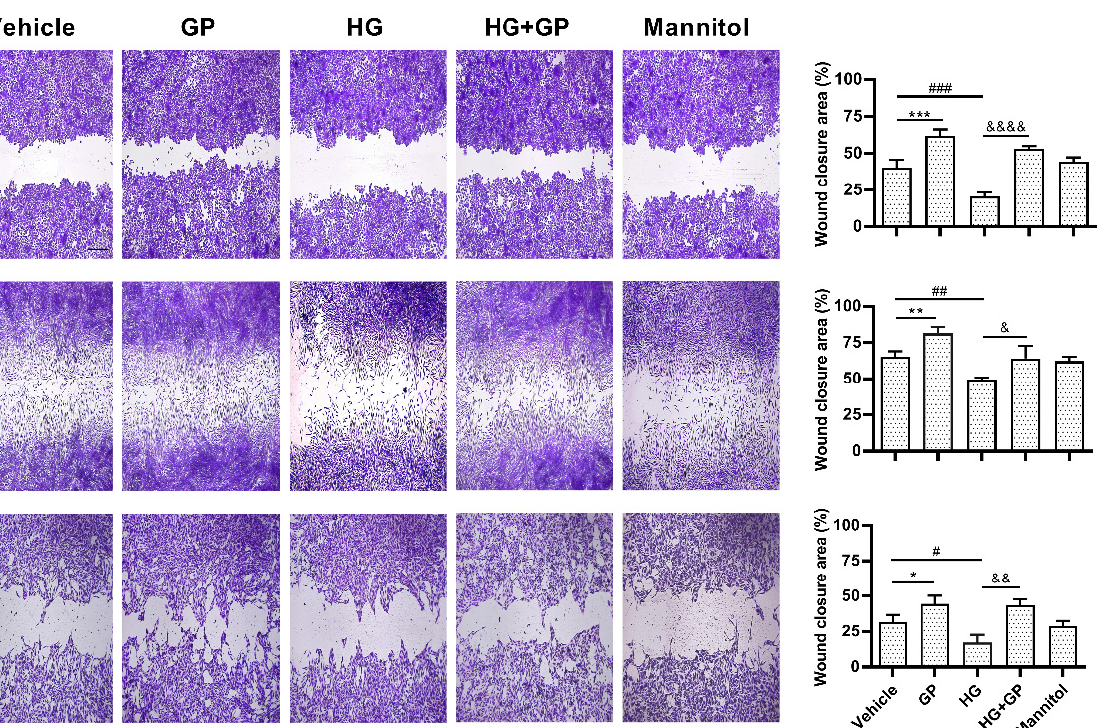
Figure 8. G. procumbens induces the migration of human keratinocytes, fibroblasts and endothelial cells under diabetic conditions. Cells were cultured in 38 mM glucose or 38 mM mannitol-containing medium for 24 h and then treated with 10 µ g/mL mitomycin C for 2 h. A scratch assay was performed and the wounded monolayers were photographed under phase-contrast microscopy. Representative photographs of ( a ) primary human keratinocytes, ( b ) fibroblasts and ( c ) endothelial cells stimulated with 50 µ g/mL G. procumbens (GP) or 0.1% DMSO in normal medium (vehicle) or 0.1% DMSO in high-glucose medium (HG) for 24 h. Right panels: the residual wound area was measured by ImageJ software. The values are presented as the means ± SD of four independent experiments. * p < 0.05, ** p < 0.01, *** p < 0.001 for the comparisons between vehicle and G. procumbens (GP) in normal medium. & p < 0.05, && p < 0.01 and &&&& p < 0.0001 for the comparison between vehicle (HG) and G. procumbens (HG+GP) in high-glucose medium. # p < 0.05, ## p < 0.01 and ### p < 0.001 for the comparisons between vehicle in normal medium and vehicle in high-glucose medium (HG).